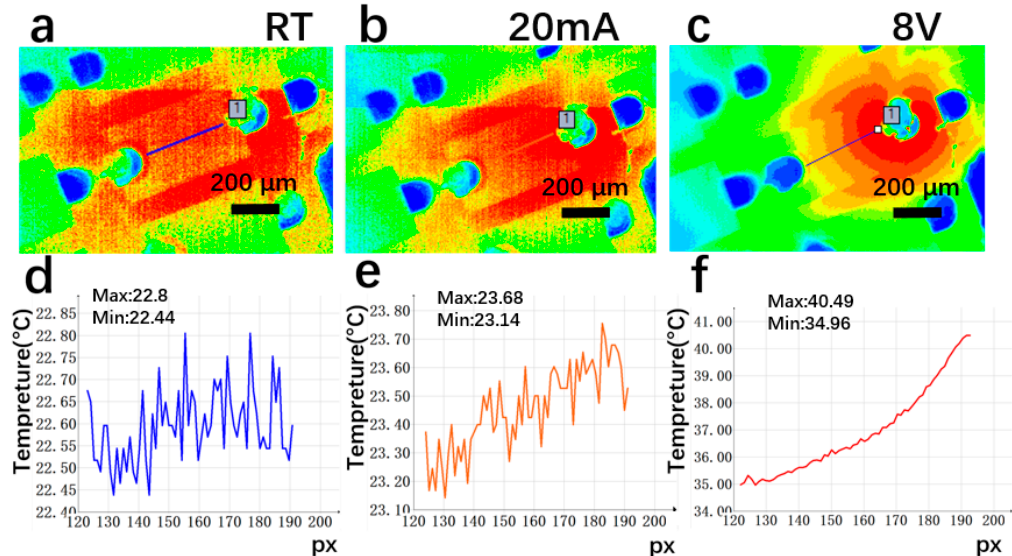
Figure 8. Temperature distribution of platinum-GLTF LEDs (sample 4). In ( b , c ), the heat is seen to spread from the p electrode side towards the n electrode side via the GLTF-based transparent electrode. Here, ( a , d ) represent room temperature with no operation; ( b , e ) represent operation at a constant current of 20 mA; and ( c , f ) represent constant voltage working mode at 8 V.